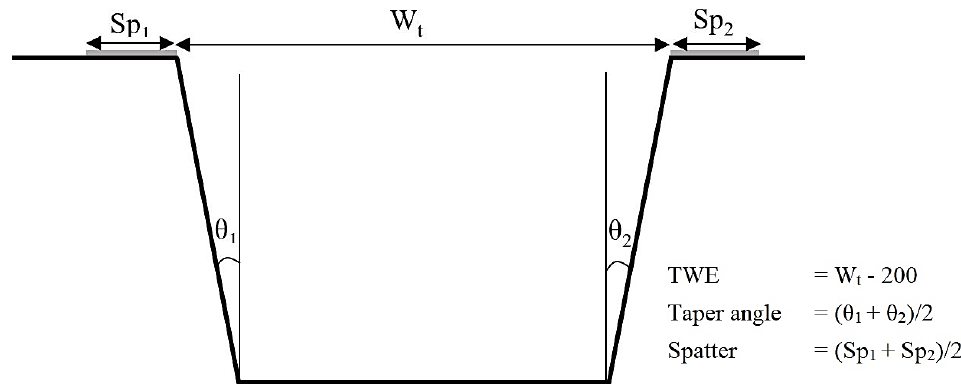
Figure 3. Schematic diagram of the microchannel cross-section detailing the output responses.